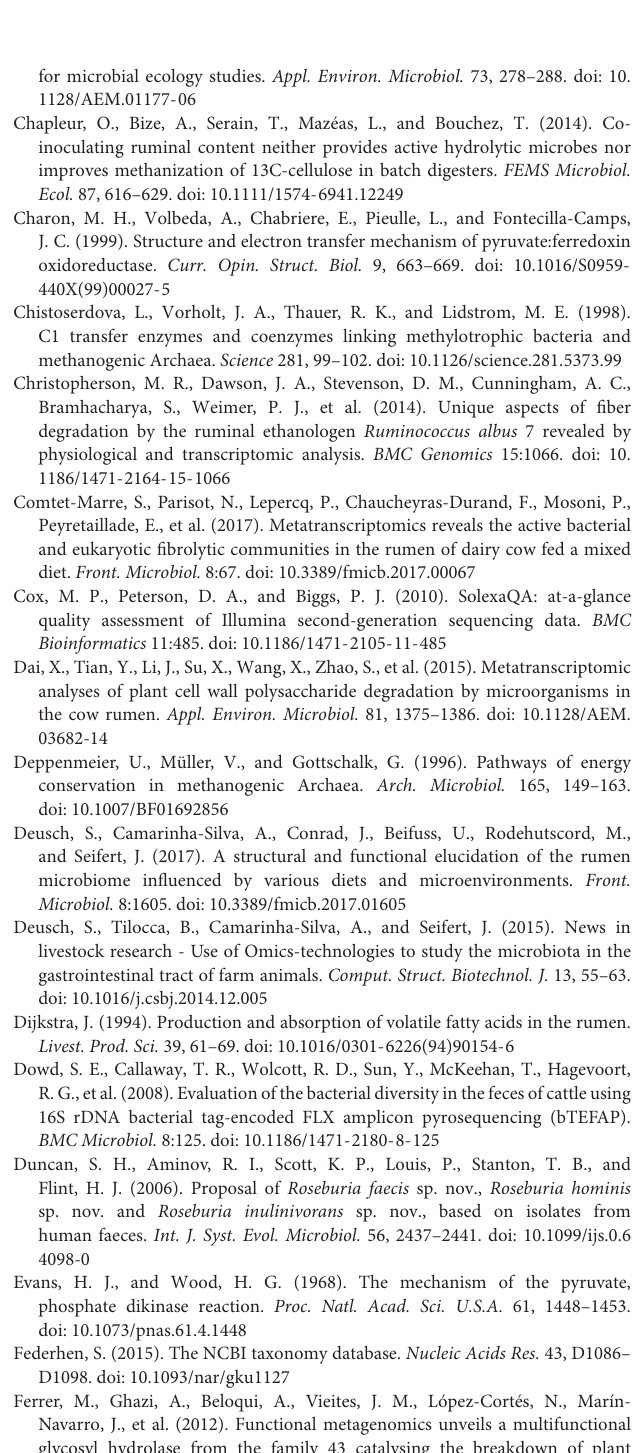
TABLE S2 | Detailed sequencing data of the metagenomics and metatranscriptomic samples. TABLE S3 | Compilation of all CAZymes identified in the rumen samples. TABLE S4 | List of all functions identified in the core, i.e., present in all 10 rumen